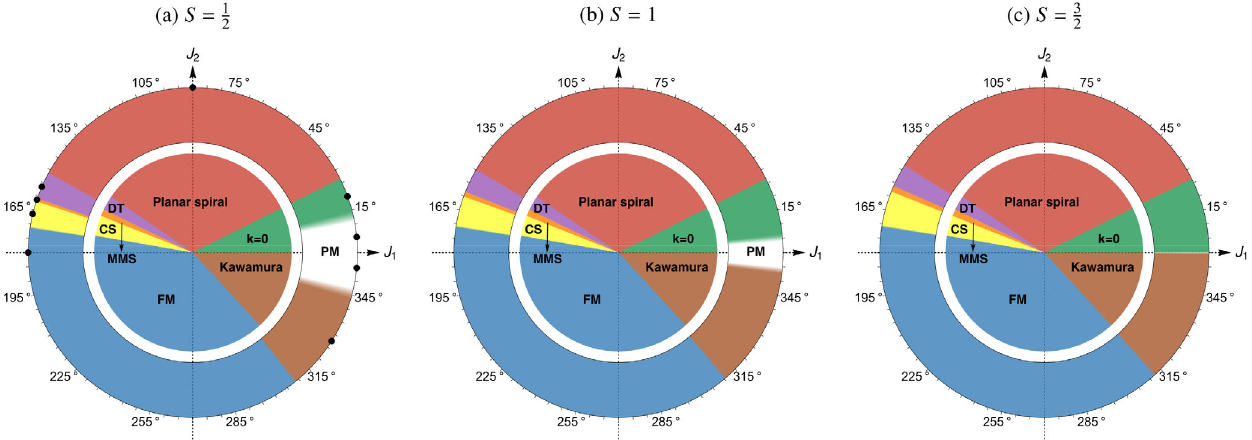
FIG. 16. The outer rings show the quantum phase diagrams of the J 1 - J 2 Heisenberg model on the pyrochlore lattice for different values of the spin S . An extended quantum paramagnetic regime is stabilized for S ¼ 1 = 2 and S ¼ 1 . The inner rings correspond to the classical phase diagram. The Heisenberg couplings are parametrized as ð J; θ Þ defined by J 1 ¼ J cos ð θ Þ and J 2 ¼ J sin ð θ Þ